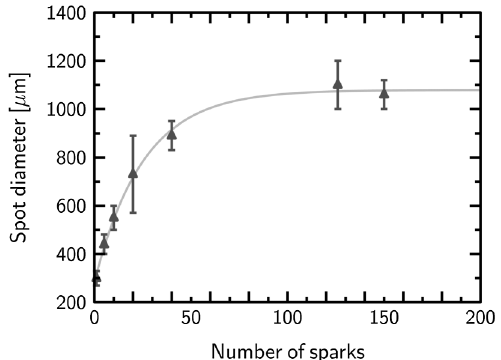
FIG. 10. Development of Mo spot size as a function of sparks; each point is an average over several measurements, all carried out with the standard capacitance, C 1 ¼ 27 : 5 nF . The solid line is a least-squares fit of the form (cid:2) a ½ 1 (cid:3) exp ð(cid:3) x=b Þ(cid:6) to the data points x